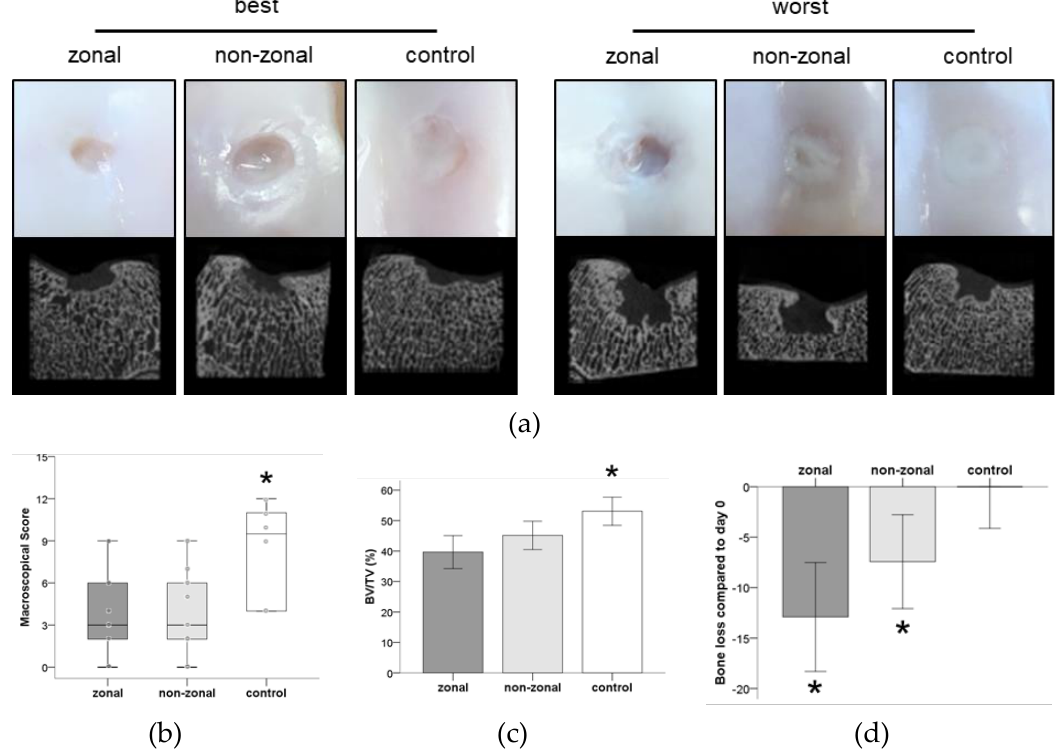
Figure 2. Macroscopy and X-ray microtomography (µCT) of treated defects after 6 months in vivo. ( a ) Shown are the best and worst µCT images and the corresponding macroscopic appearance per group. ( b ) International Cartilage Repair Society (ICRS) score determined by three blinded observers resulted in a significantly better score of empty defects compared to both treatment groups. Boxes represent first and third quartiles, medians are given as horizontal lines, whiskers are maximal and minimal values, individual values (mean of all three observers) are depicted as circles. *: p ≤ 0.05